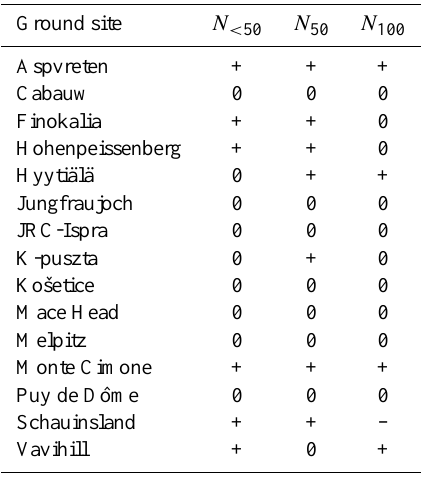
Table 4. Summary of the ground sites at which a statisti- cal improvement in the predicted hourly-mean number concen- tration is achieved by including BL nucleation in the model. The results are given for particle number concentrations in three size ranges; D p =15–50nm ( N < 50 ), D p > 50nm ( N 50 ), and D p > 100nm ( N 100 ). The “+” sign indicates where a statistically significant difference between the model and observations is re- moved by including BL nucleation. The “–” sign indicates where the reverse occurs i.e. including BL nucleation leads to a statistically significant overprediction of the observed N < 50 , N 50 , or N 100 . “0” indicates where there is no statistically significant change in the pre- dicted particle number concentrations with BL